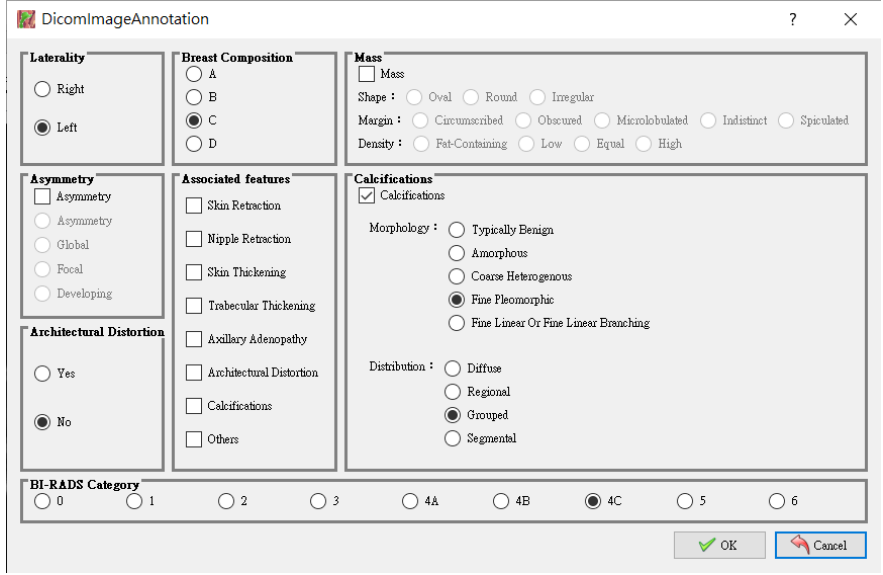
Figure 1. An interface for breast lesion annotation.